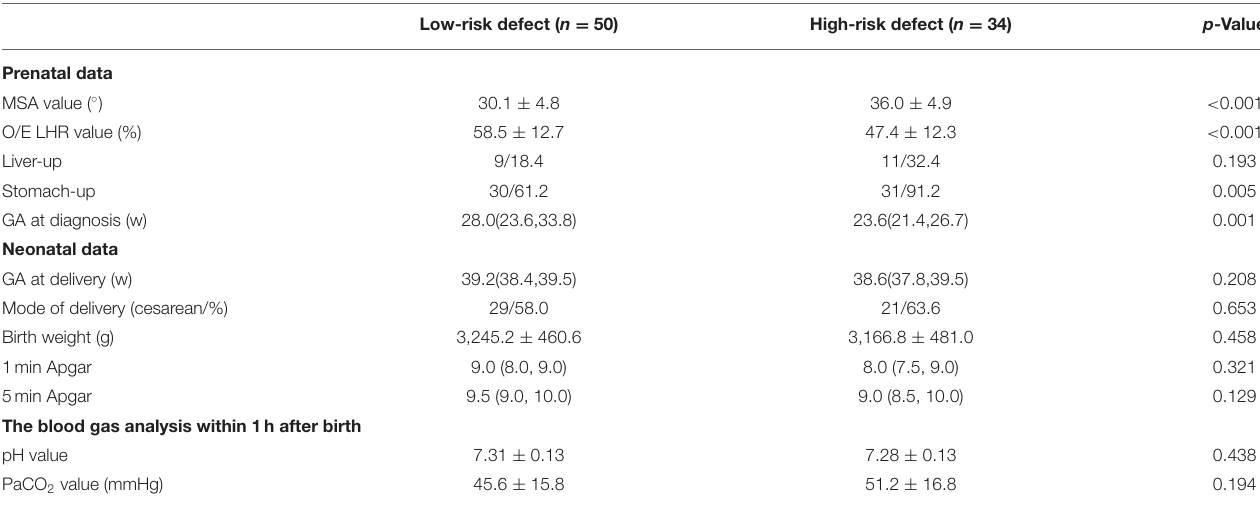
TABLE 2 | Pre- and neonatal clinical outcomes according to the severity. Low-risk defect ( n = 50) High-risk defect ( n = 34) p